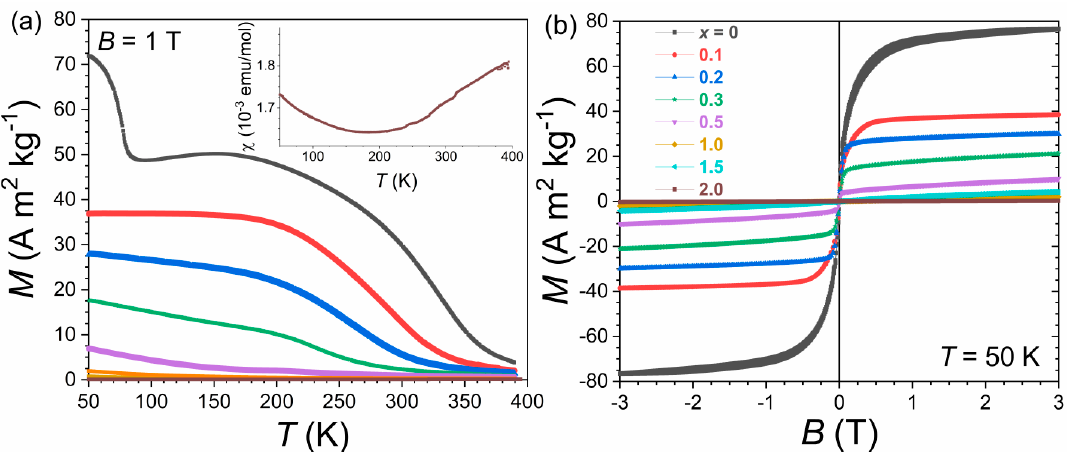
Figure 4. Magnetic properties of Sc 0.28 Ti 0.72 Fe 2 − x Co x alloys as a function of Co content ( x ): ( a ) magnetization versus temperature upon heating in B = 1 T, in inset magnetic susceptibility for x = 2; ( b ) hysteresis loop at T = 50 K.